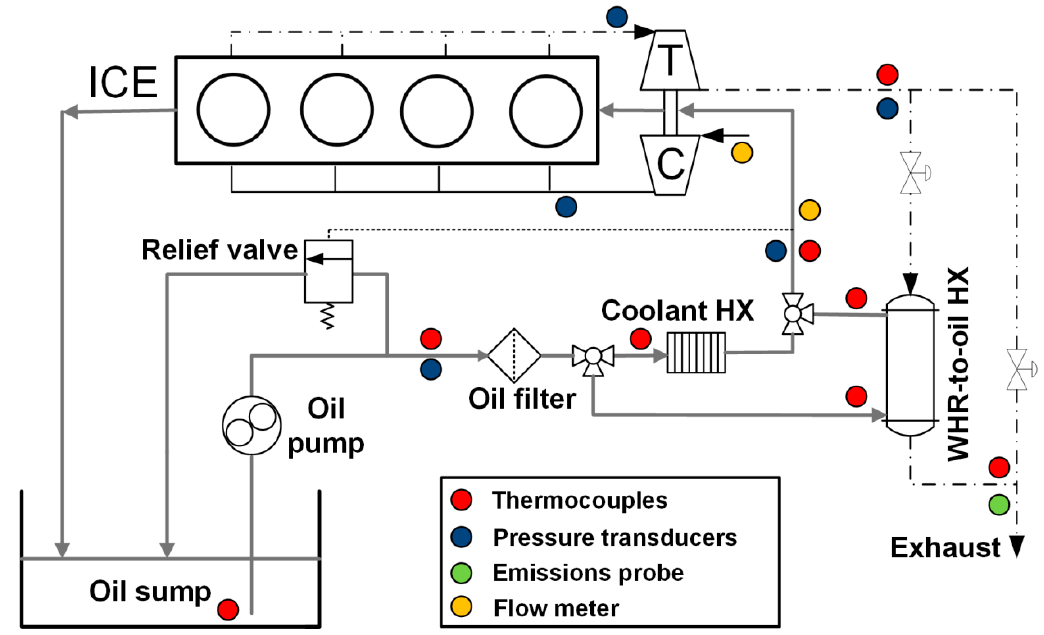
Figure 1. Engine oil circuit layout with Waste Heat Recovery.